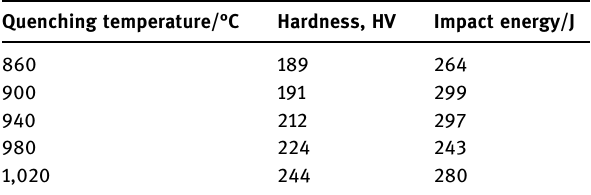
Table 4: Low temperature impact energy and microhardness of experimental steels at di ff erent quenching temperatures Quenching temperature/°C